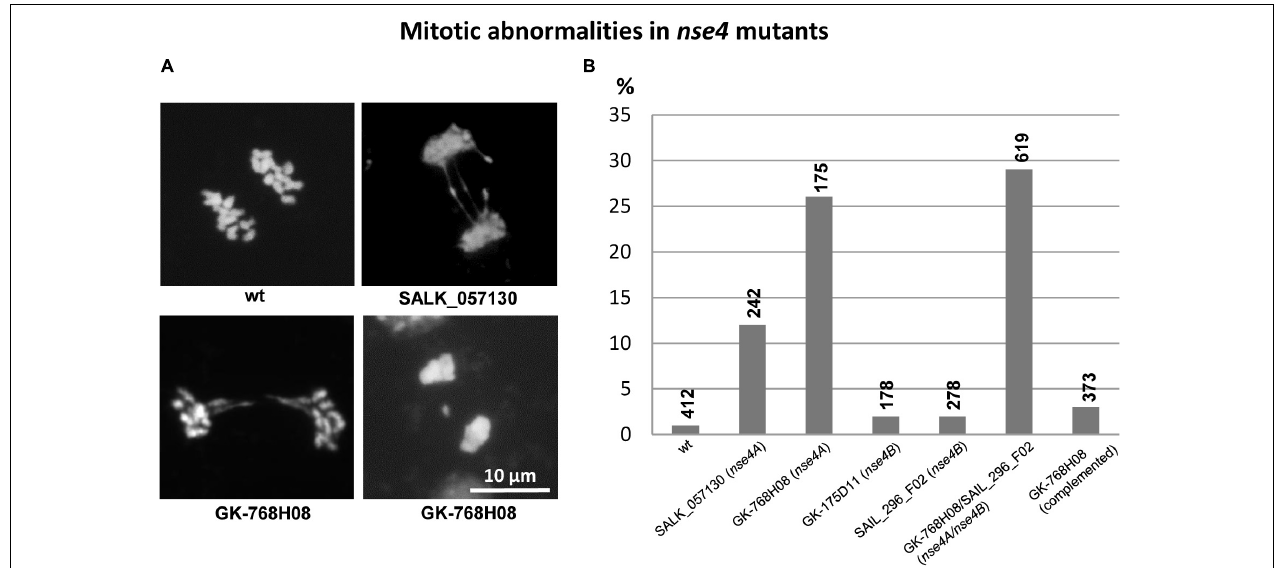
FIGURE 5 | Mitotic defects (anaphase bridges, laggards) in somatic flower bud nuclei of the A. thaliana nse4 mutants (A) . The diagram (B) indicates the frequency (%) of abnormalities in the mutants compared to wild-type. The percentage of abnormalities is clearly increased in the nse4A mutants SALK_057130 and GK-768H08, as well as in the homozygous double mutant GK-768H08/SAIL_296_F02 representing both nse4A and nse4B mutations, respectively. The complementation of the mutation in GK-768H08 clearly decreases the number of abnormalities indicating that they are induced by the dysfunction of the Nse4A gene. The numbers of cells analyzed are indicated above the diagram